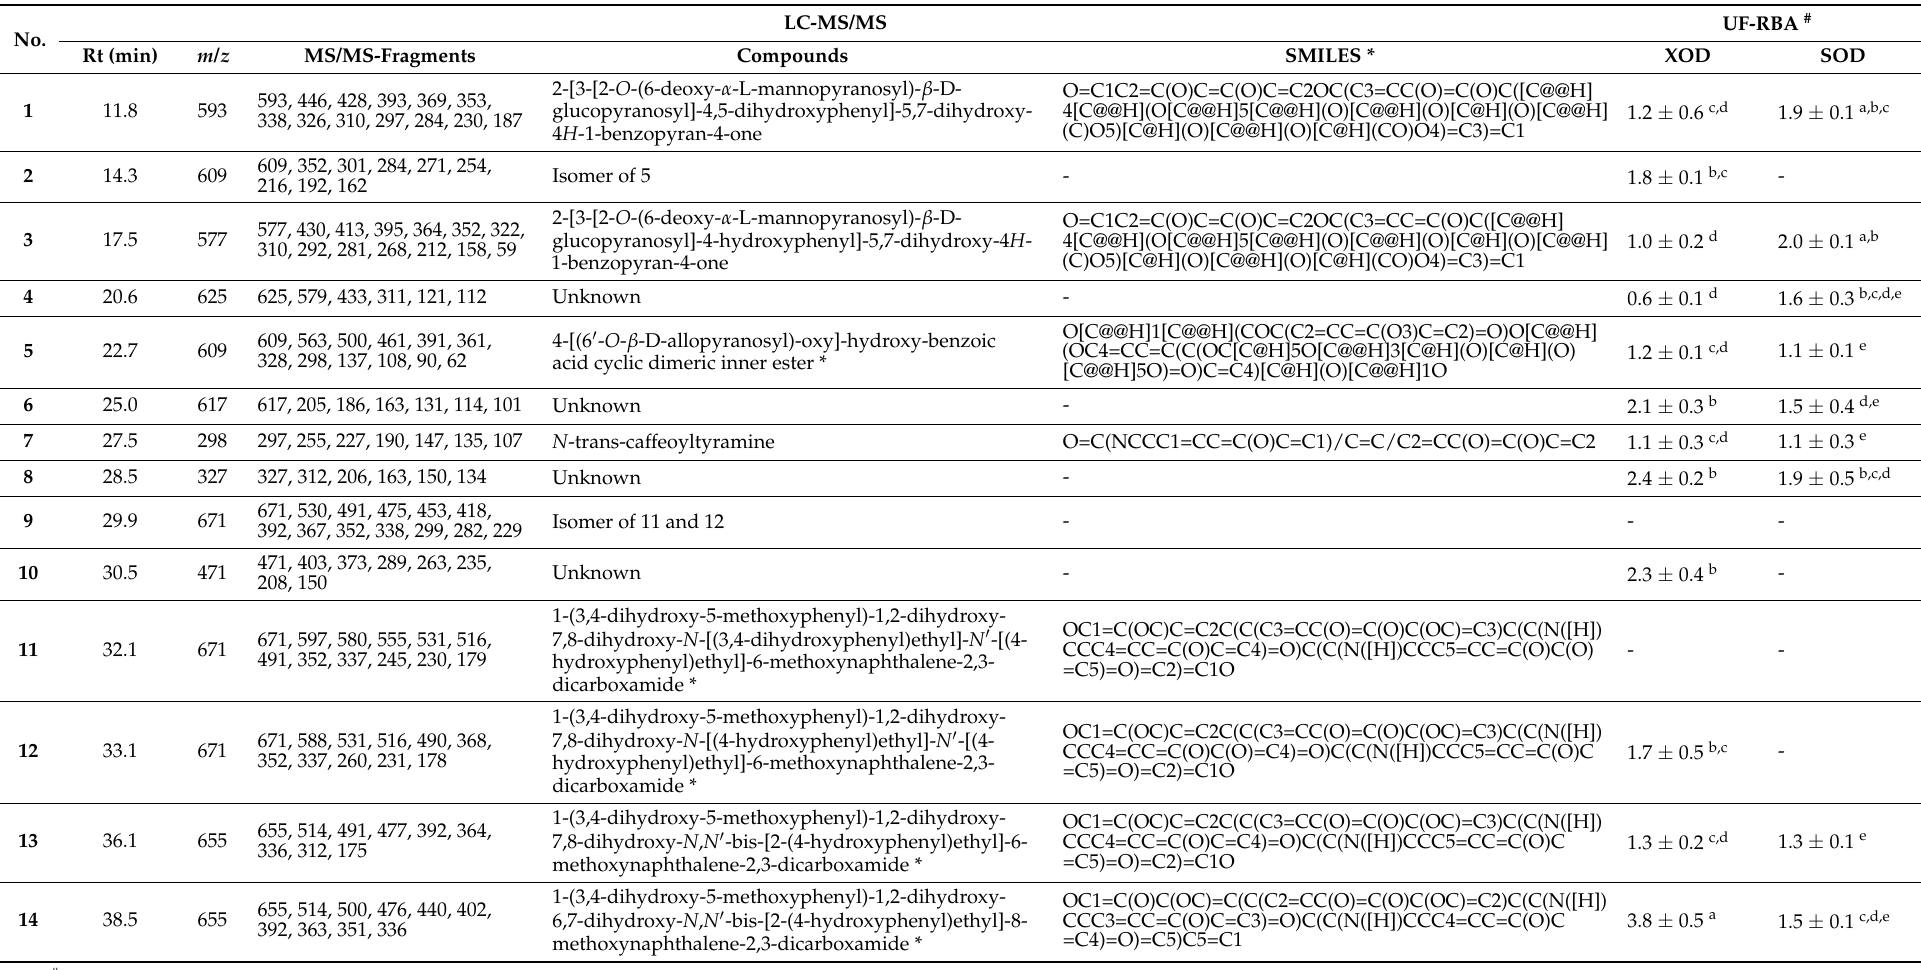
Table 3. The identification and RBAs of potential ligands against xanthine oxidase and superoxide dismutase in